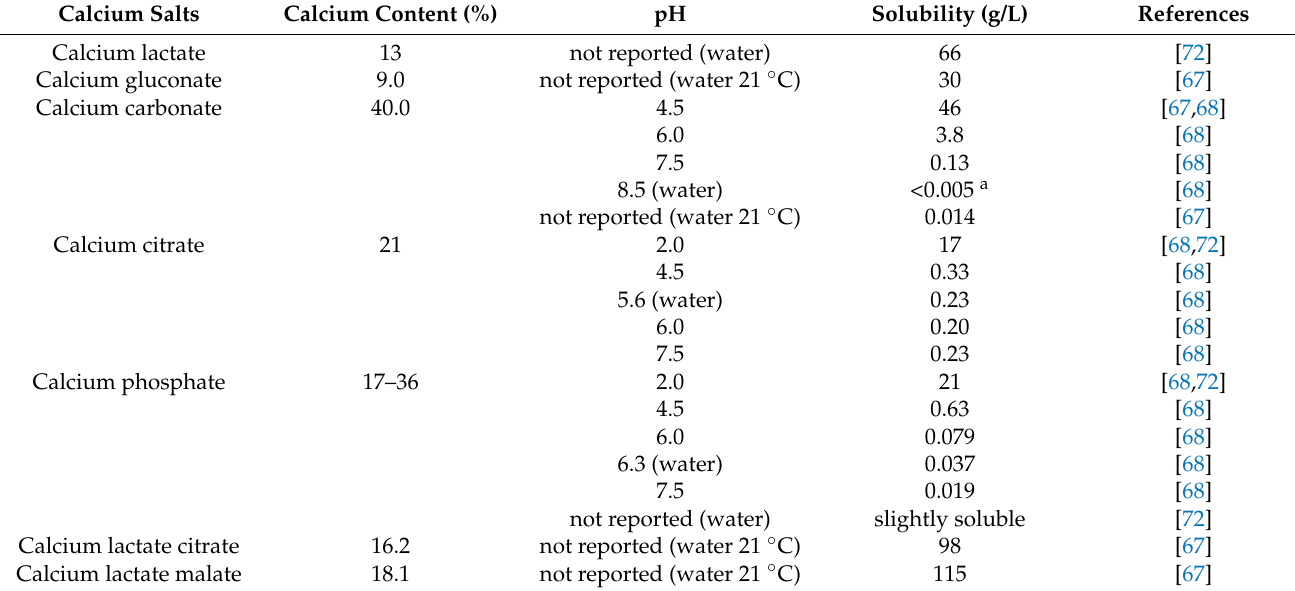
Table 3. Calcium content, pH and solubility of various calcium